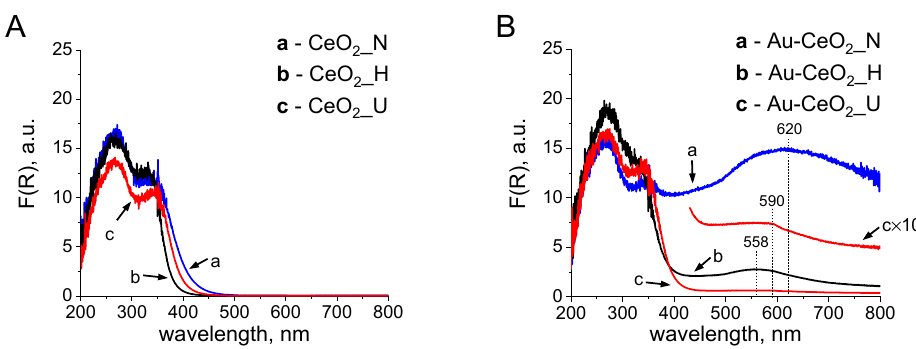
Figure 6. ( A , B ) Diffuse Reflectance UV-vis spectra of catalysts.